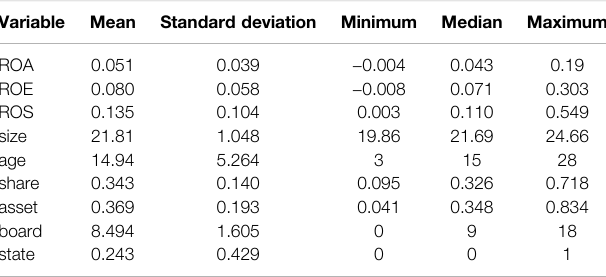
TABLE 3 | Descriptive statistics of main variables.